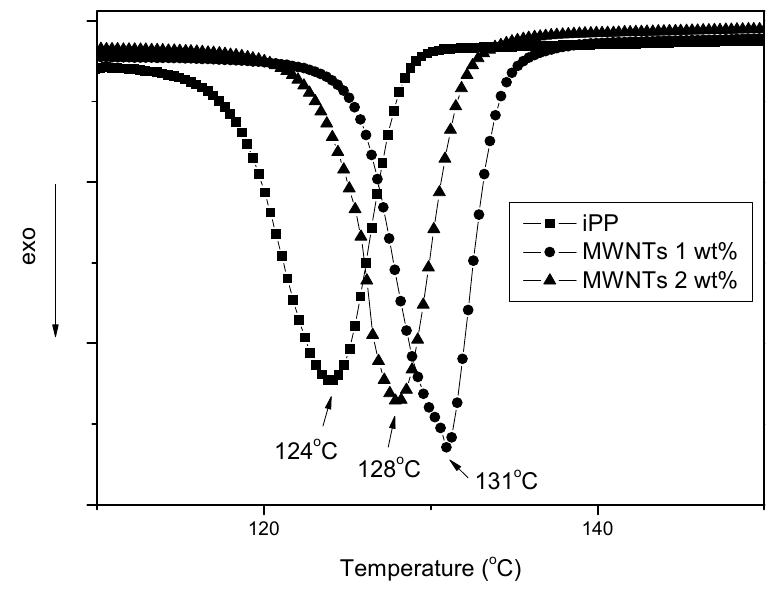
Figure 23. Nonisothermal crystallization curves of PP and PP/MWCNTs composites.